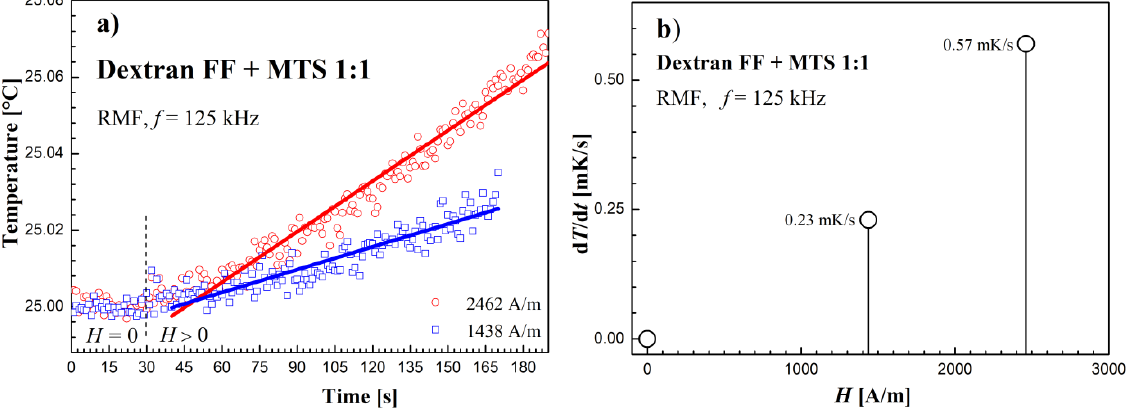
Figure 8. ( a ) Time courses of temperature changes in the dextran with magnetosomes sample. ( b ) d T /d t values depending on the amplitude of the magnetic field strength H in the RMF at the frequency f = 125